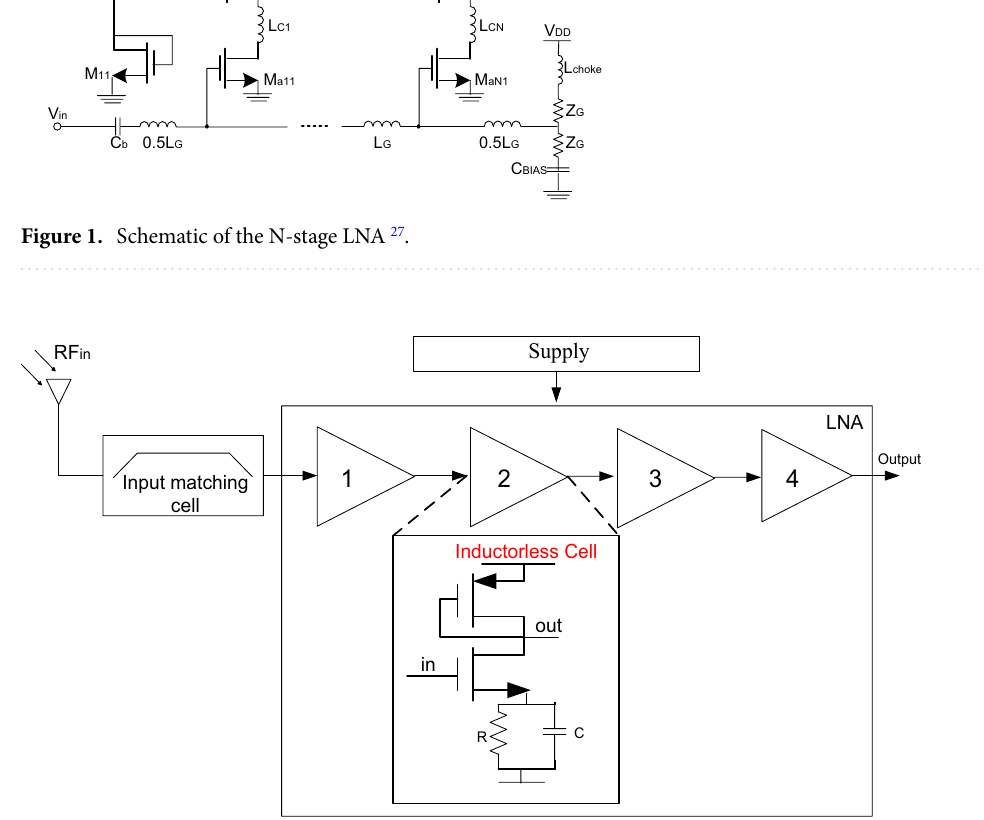
Figure 2. The cascaded LNA